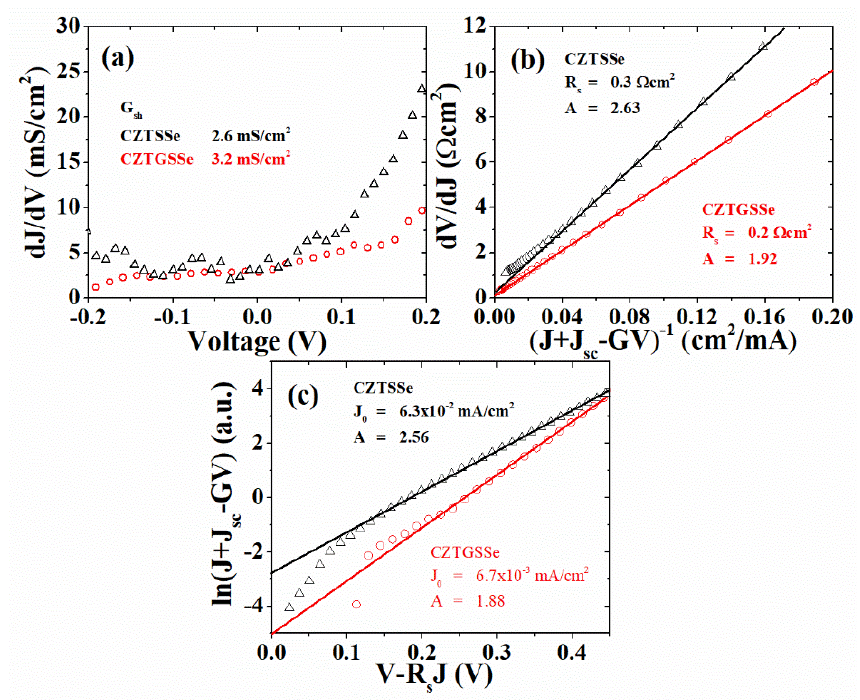
Figure 6. J–V analysis of the CZTSSe and CZTGSSe solar cells: ( a ) G sh ; ( b ) R s and A; ( c ) J 0 and A. Figure 6. J – V analysis of the CZTSSe and CZTGSSe solar cells: ( a ) G